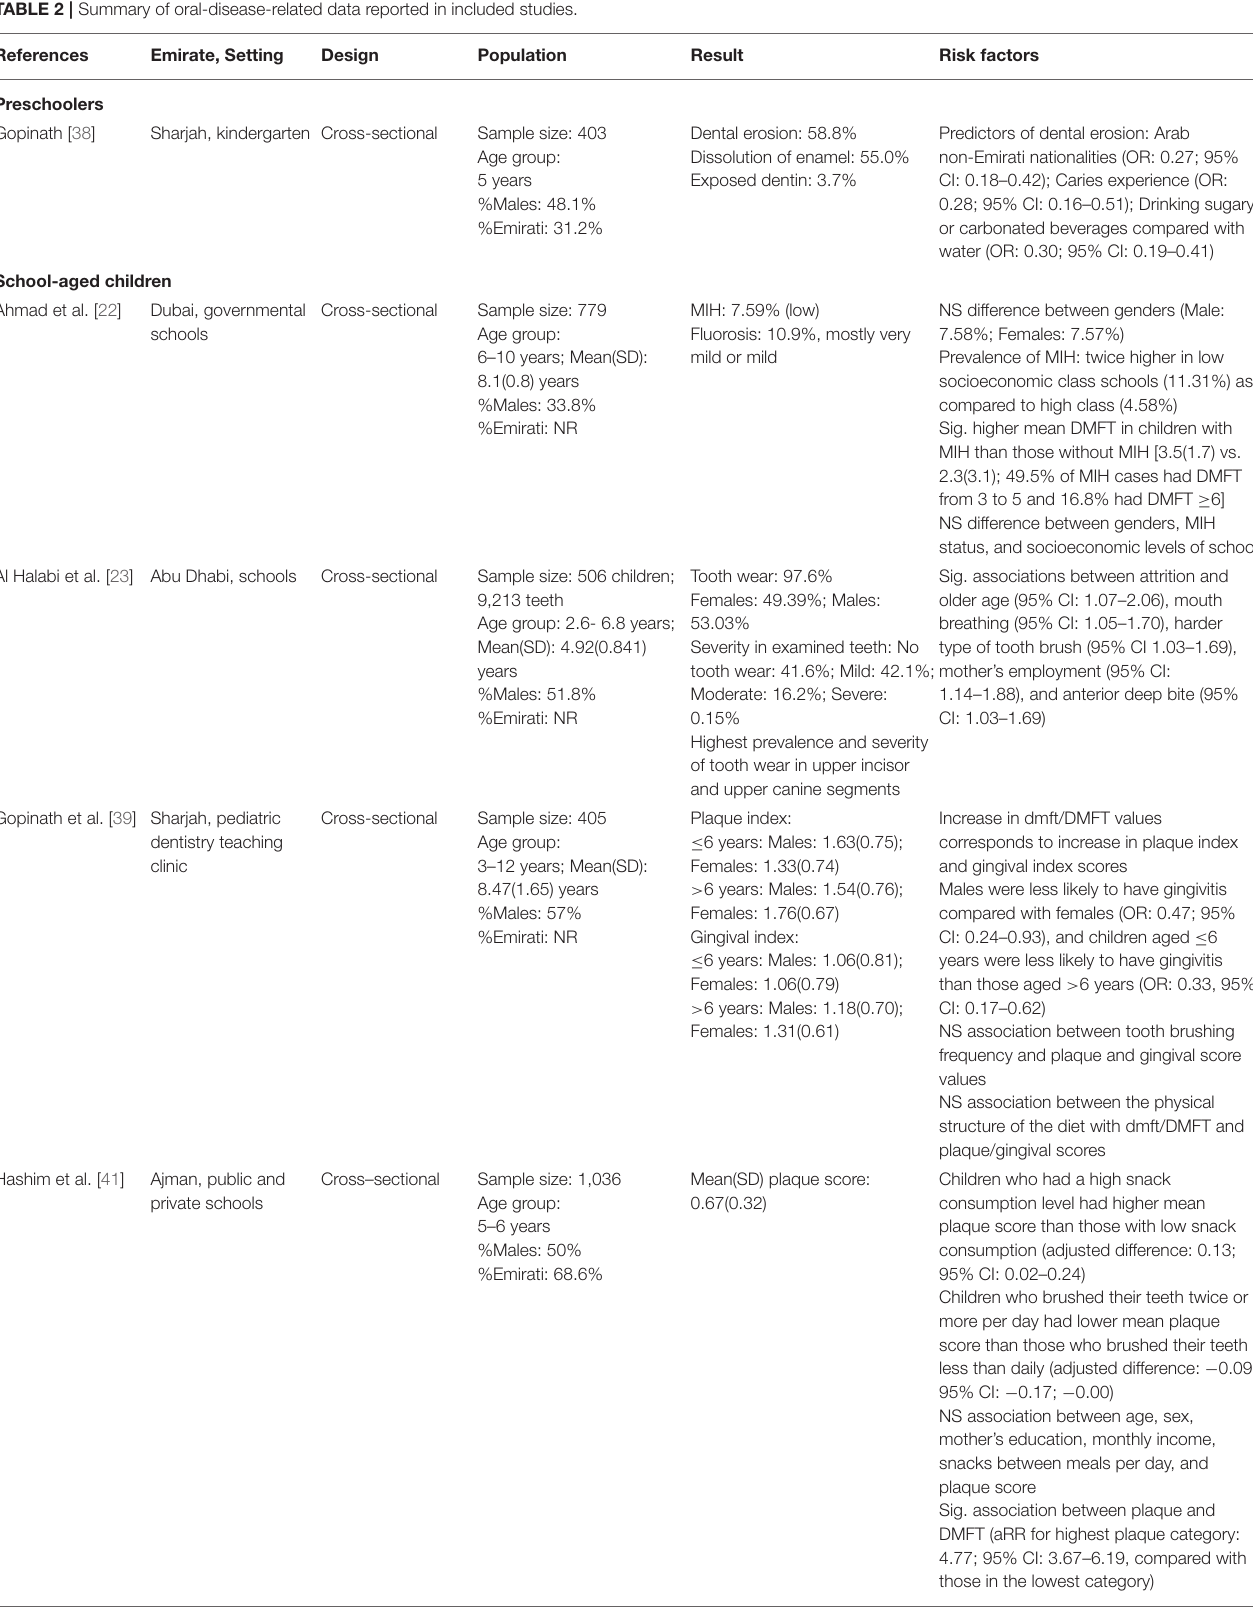
TABLE 2 | Summary of oral-disease-related data reported in included